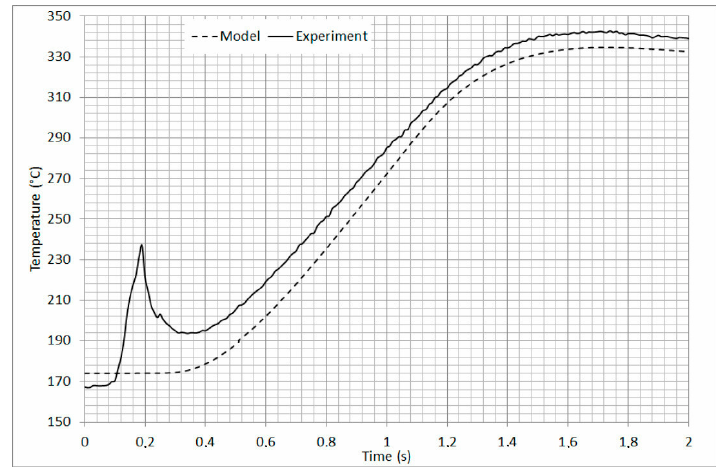
Figure 9. Experimental and numerical temperature versus time profile at a 5 mm distance from the droplet axis.